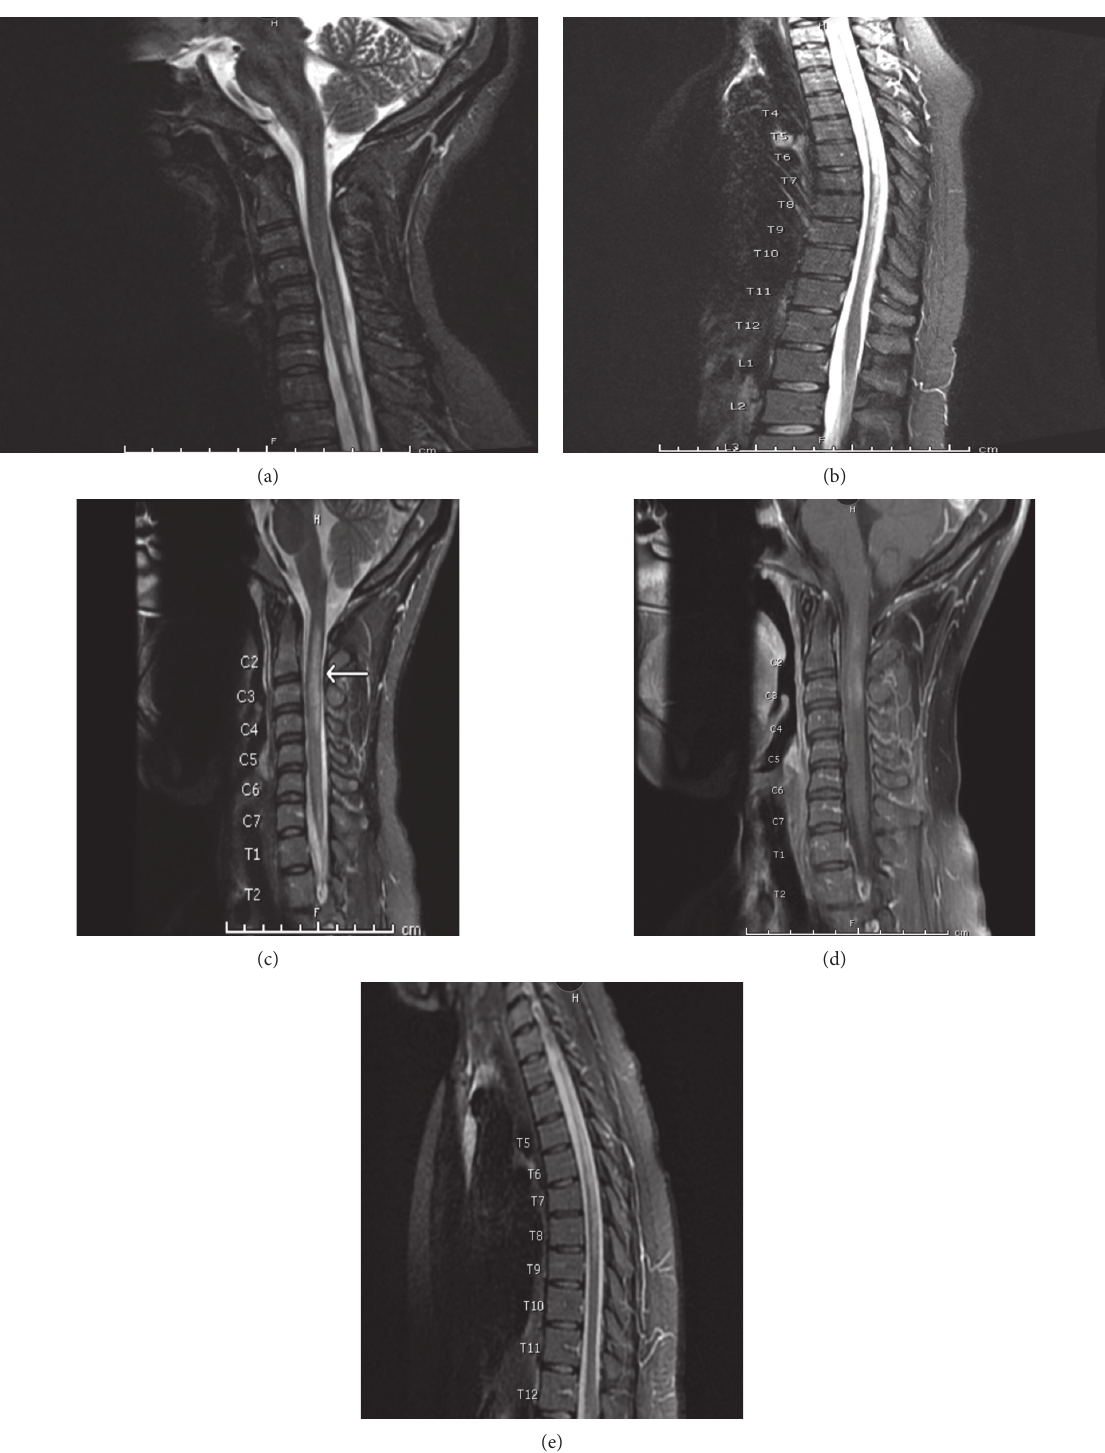
Figure 1: T2WI of cervical and thoracic spine of a 31-year-old African American woman with NMOSD and SLE. In 2018, cervical (a) and thoracic spine (b) demonstrated a C6 hyperintense lesion extending to T8 (a, b), which was unchanged from a prior spine MRI of the patient (not shown). In 2019, there was a new C2–C4 longitudinal lesion noted on the C spine on T2WI (c) with associated patchy postcontrast enhancement on T1WI (d) and an ongoing hyperintense lesion in the T spine extending to T8